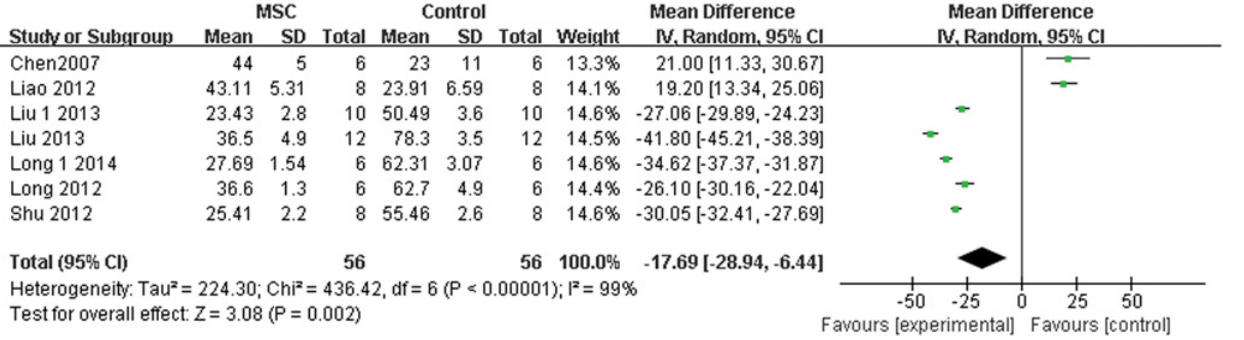
Fig 5. Forest plot showing the impact of mesenchymal stem cell (MSC) therapy on the positive expression of proliferating cell nuclear antigen (PCNA), compared with controls. Abbreviations: SD = standard deviation, IV = independent variable, 95% CI = 95% confidence interval.